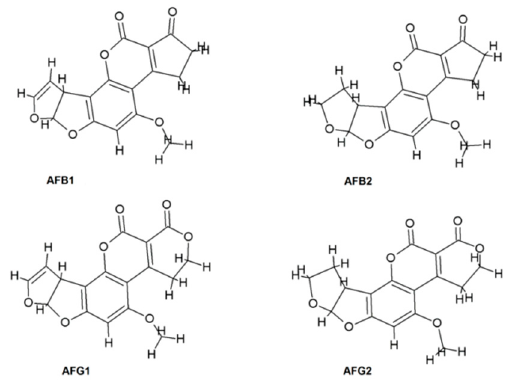
Figure 1. Aflatoxins’ chemical structure.